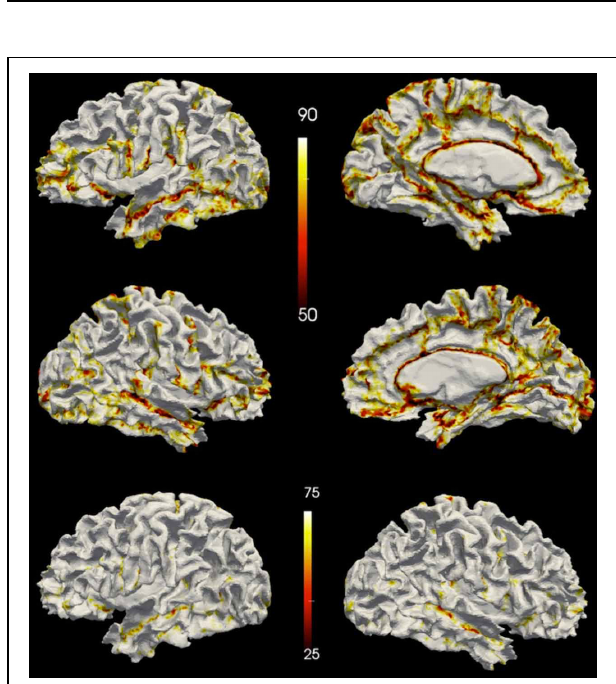
FIGURE 7 | The accuracy over the testing set visualized on a surface. The top row shows accuracy on the left hemisphere and the central row shows accuracy on the right hemisphere. The bottom row shows the accuracy on the left hemisphere of the same subject as the top row but with a different scaling. Top two rows share the scale of 50 ∼ 90%, while the bottom row uses the same scale (25% ∼ 75%) as being utilized in FreeSurfer’s paper (Fischl et al., 2004).